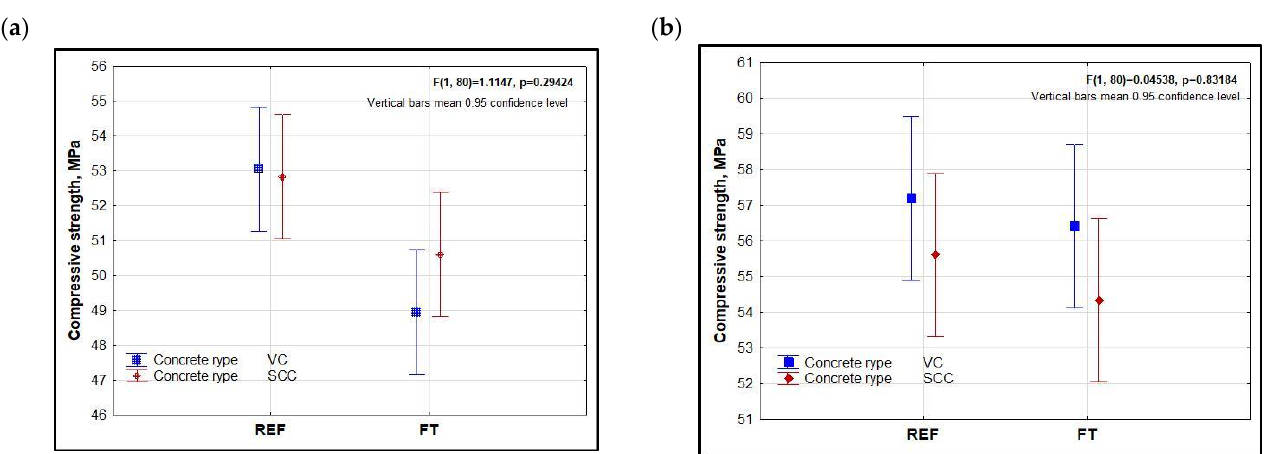
Figure 13. ANOVA analysis of the effect of concrete type on the compressive strength for reference samples and samples after 100 cycles of freeze – thaw for ( a ) concretes without AEA and ( b ) concretes with AEA.